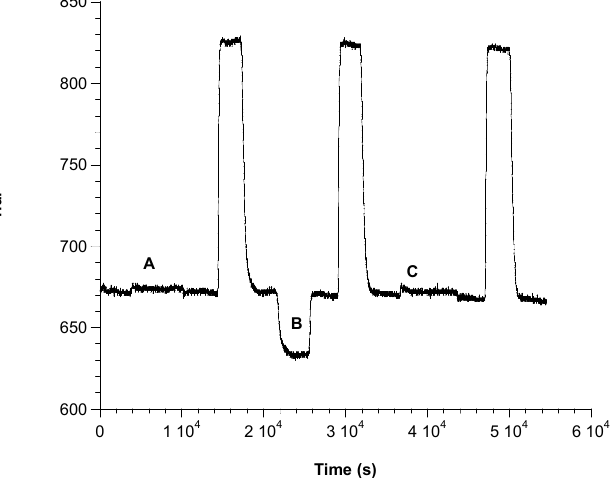
Figure 11. Selectivity test: ( A ) Fosfomycin 1 × 10 − 3 M; ( B ) Erythromicin 5 × 10 − 3 M; ( C ) Ceftriaxone 4 × 10 − 3 M.